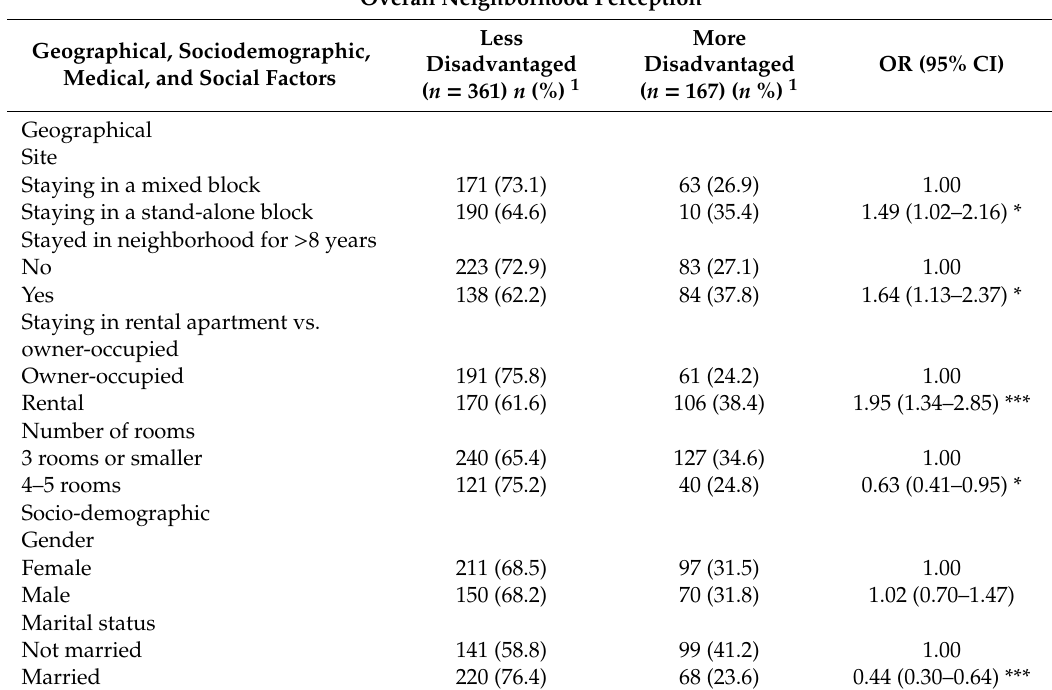
Table 1. Associations between overall neighborhood perception and geographical, sociodemographic, medical, andsocialfactors, amongstresidentsintwopublichousingprecinctsinSingapore, onunivariate analysis ( n =